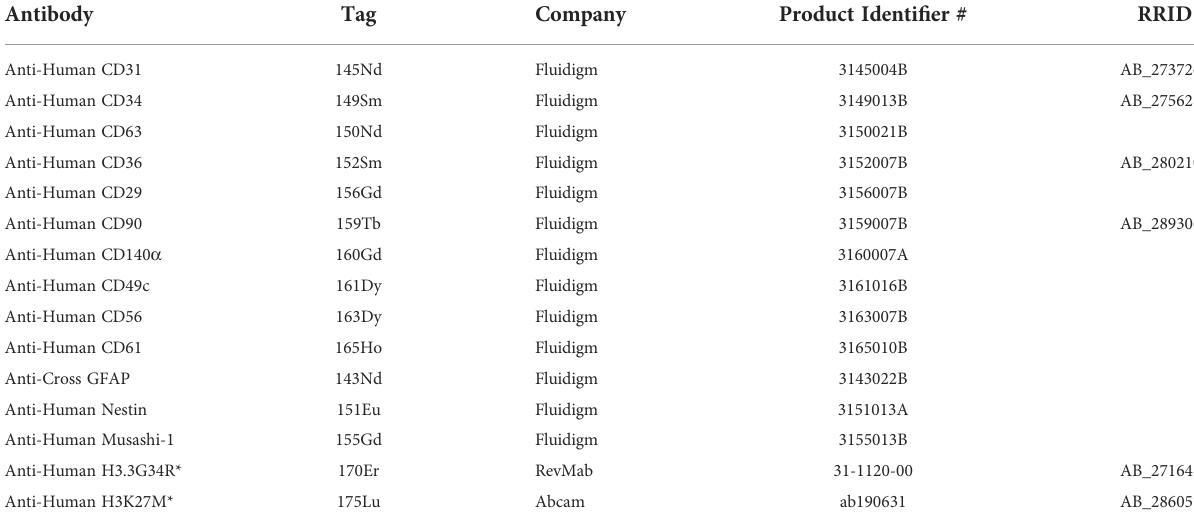
TABLE 1 Summary of the 15 antibodies used for the mass cytometry analysis.